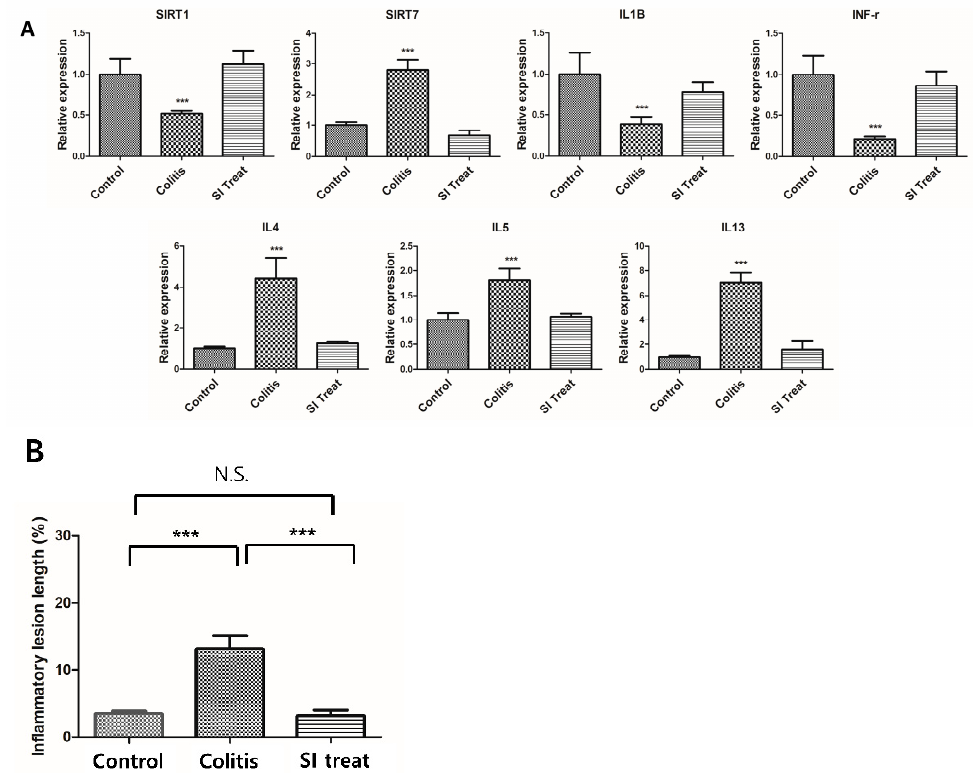
Figure 4. SIRT7 inhibitor reduced colonic inflammation. ( A ) Comparison of SIRT1, SIRT7, and inflammatory cytokine expression in the colon mucosa between the control, colitis, and SIRT7 inhibitor (SI)-treated groups with qRT-PCR. ( B ) The calculated area of the intestinal mucosa with inflammatory cell infiltration was compared to the total mucosal area of the sample. The percentage of the inflammatory area was compared among the groups. *** p < 0.05. N.S., not significant.